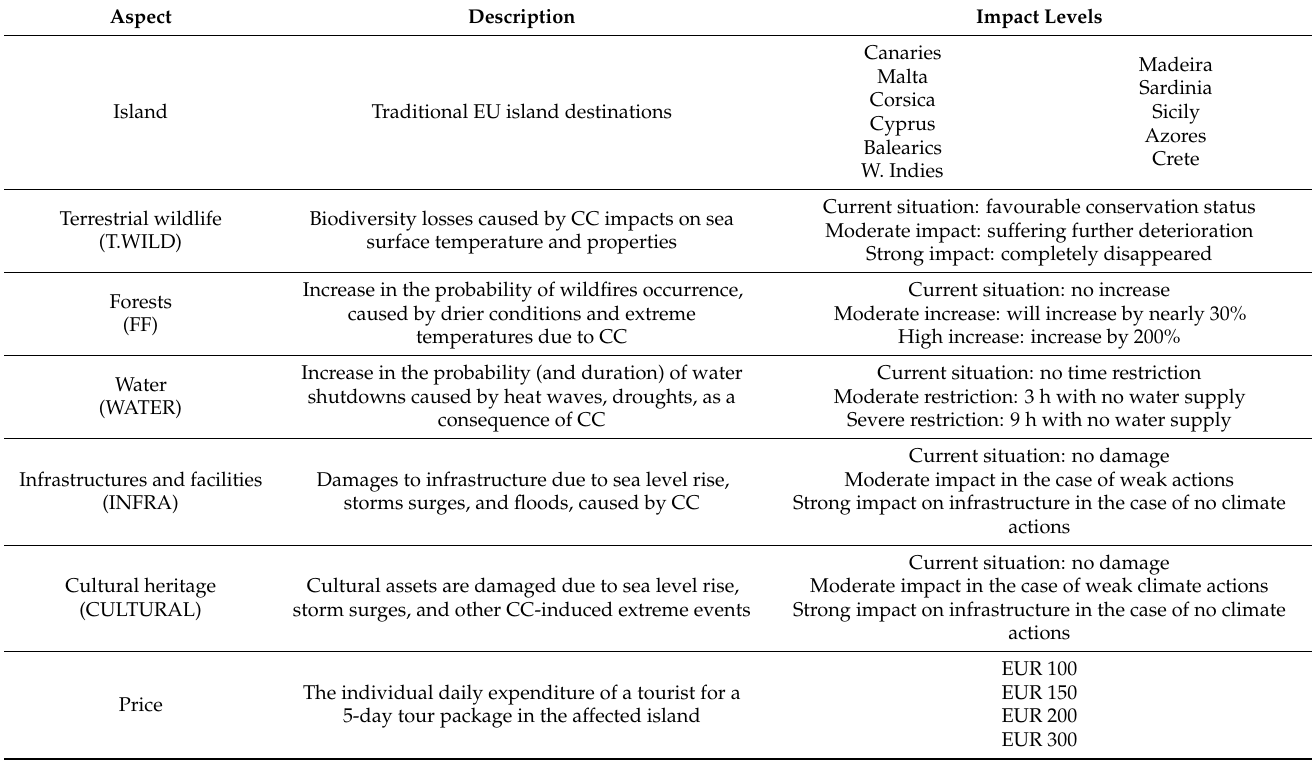
Table 1. Attributes and impact levels included in the